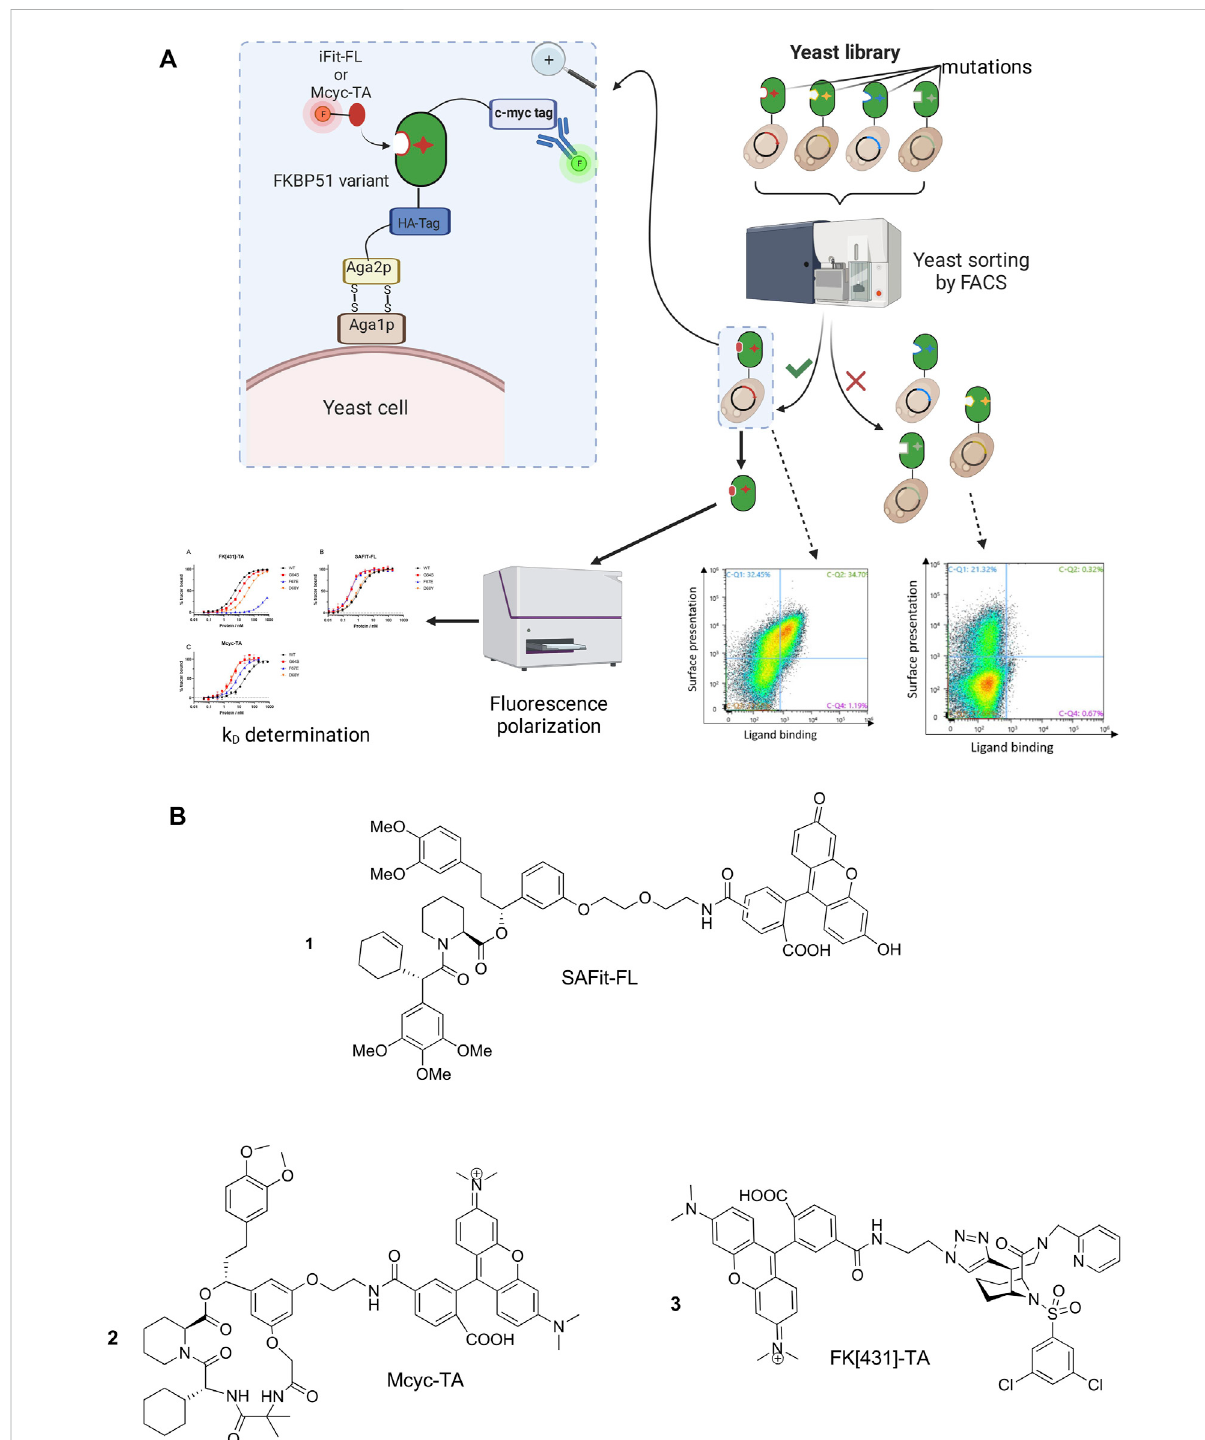
FIGURE 2 (A) Schematicrepresentationoftheyeastsurfacedisplay(YSD)presentingmutatedFKBP51variants,FACS-basedscreeningstrategy andaf fi nity determination. Created with BioRender.com. (B) Chemical structure of the FKBP tracers SAFit-FL (out/in) (1), Mcyc-TA (out/out) (2), and FK [431]-TA (in/ in)